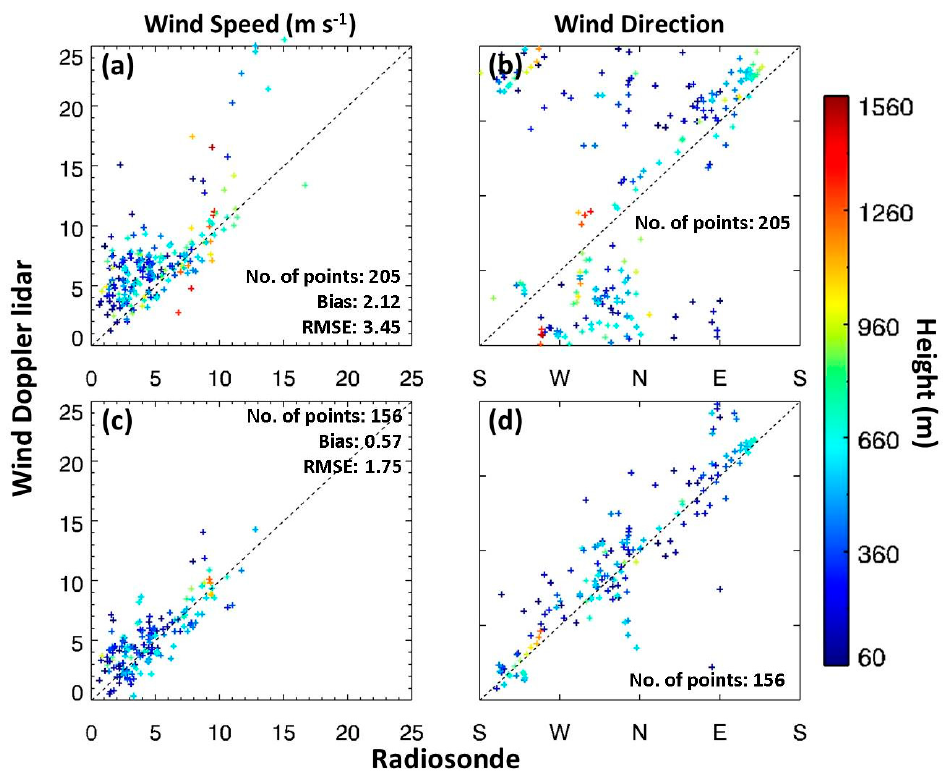
Figure 5. Scatter plot of wind speed (left column: a,c ) and direction (right column: b , d ) from radiosonde soundings ( x -axis) and wind Doppler lidar measurements ( y -axis), using the sine-fitting method (upper panel: a , b ) and the SVD method (lower panel: c , d ).